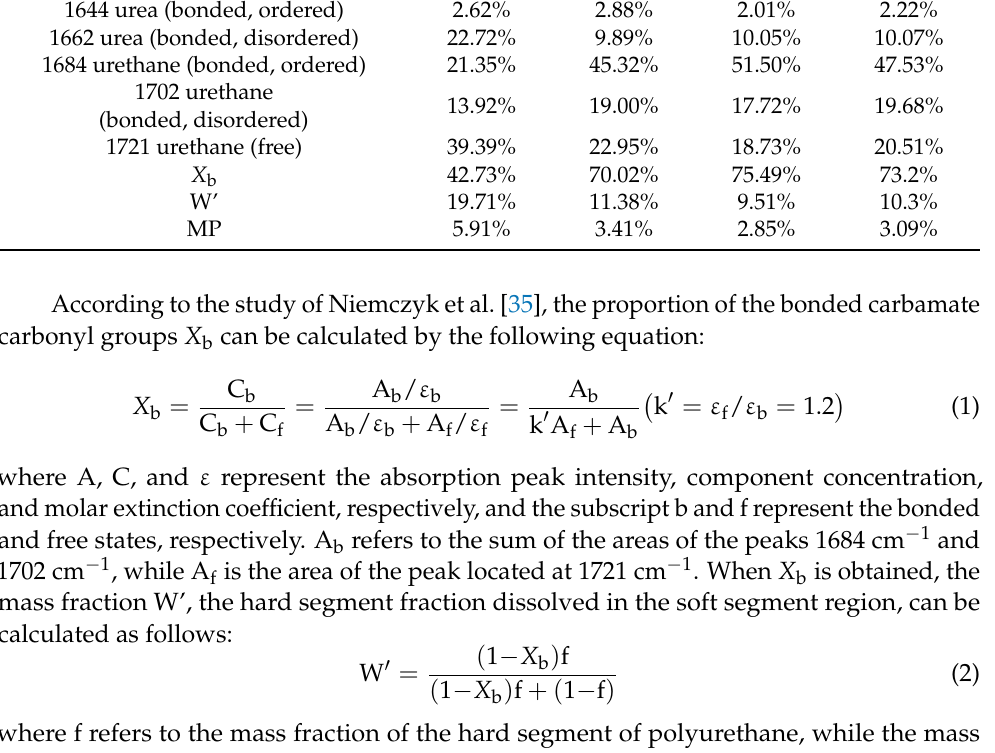
Table 2. PEU infrared carbonyl region fitting peak attributions and proportions.